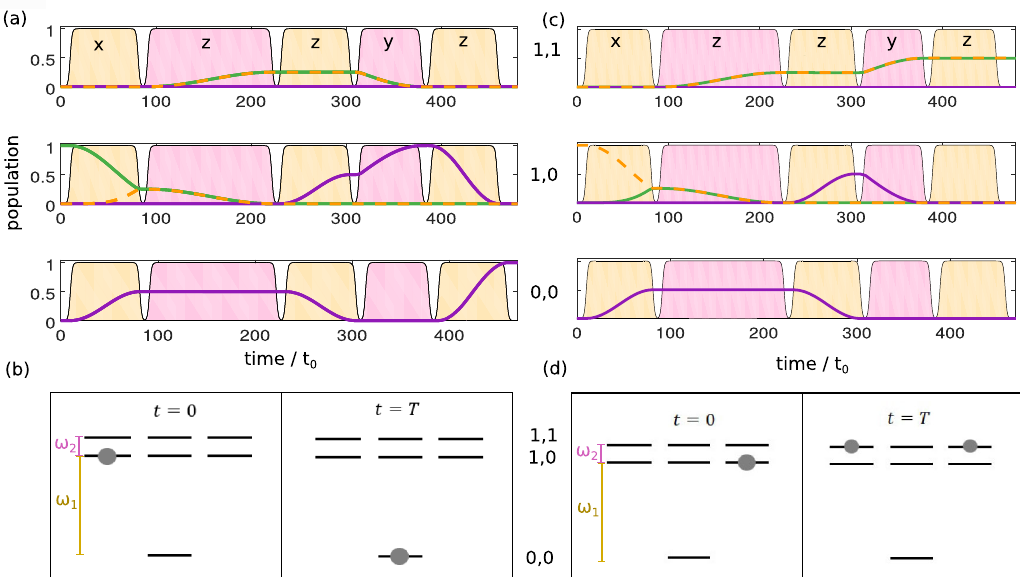
Fig. 4 Control of rotational dynamics to energetically separate degenerate initial states. a and b These depict the population dynamics for the initial state J ¼ 1 ; τ ¼ 0 ; M ¼ (cid:2) 1 j i and c and d display the dynamics for the initial state J ¼ 1 ; τ ¼ 0 ; M ¼ 1 j i , where J , τ , and M are the quantum numbers of the asymmetric top. a and c show the population in the rotational levels J , τ = 1, 1, J , τ = 1, 0 and J , τ = 0, 0. The population dynamics of the degenerate states are depicted by green ( M = − 1), purple ( M = 0), and orange ( M = 1) lines. The envelope of the pulses is indicated by the orange (frequency ω = ω 1 ) and pink ( ω = ω 2 ) shapes, and x , y , and z denote the polarization of the corresponding fi elds. Time is given in units of t 0 = ℏ / B . The initial ( t = 0) and fi nal ( t = T ) states are sketched in b and d . The gray dots indicate the initially populated states J ¼ 1 ; τ ¼ 0 ; M ¼ (cid:2) 1